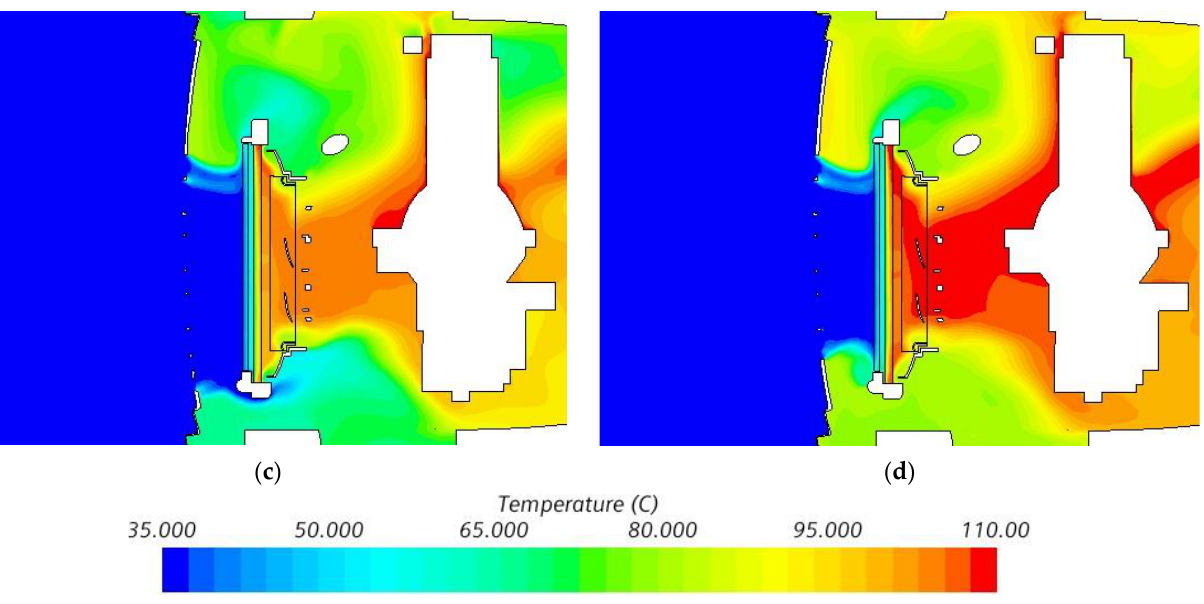
Figure 24. Temperature fields of z = 0.08 m section under different grille closure schemes: ( a ) original vehicle; ( b ) scheme 1; ( c ) scheme 2; ( d ) scheme 3.